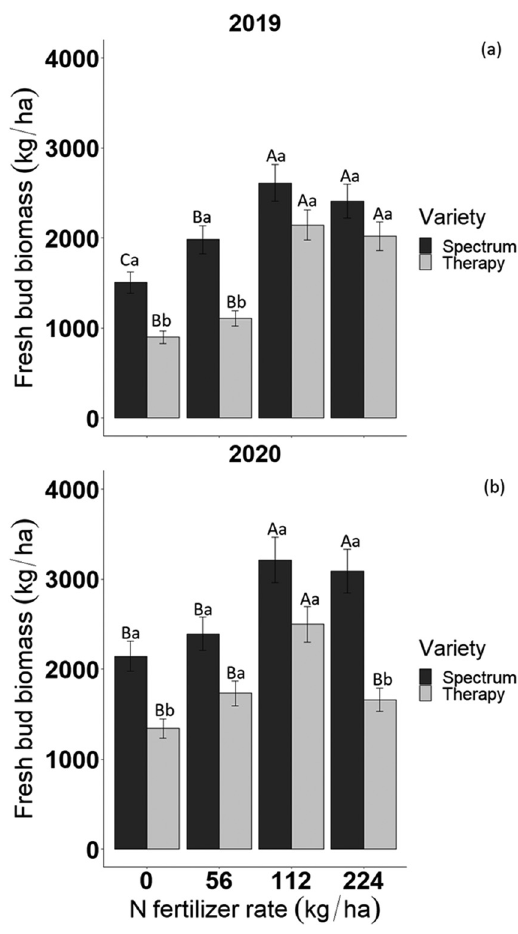
Figure 1: Interaction e ff ects of nitrogen fertilization with year and CBD hemp varieties on fresh bud biomass in ( a ) year 2019 and ( b ) year 2020. Mean values designated by di ff erent lower - case letters indicate a signi fi cant di ff erence between varieties at the same fer - tilizer level and mean values designated by di ff erent upper - case letters indicate a signi fi cant di ff erence between N fertilizer rates for the same